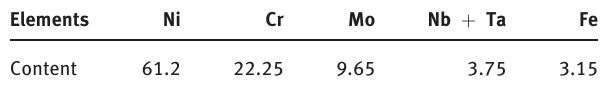
Table 1: Main chemical composition of Inconel 625 alloy (mass %). Elements